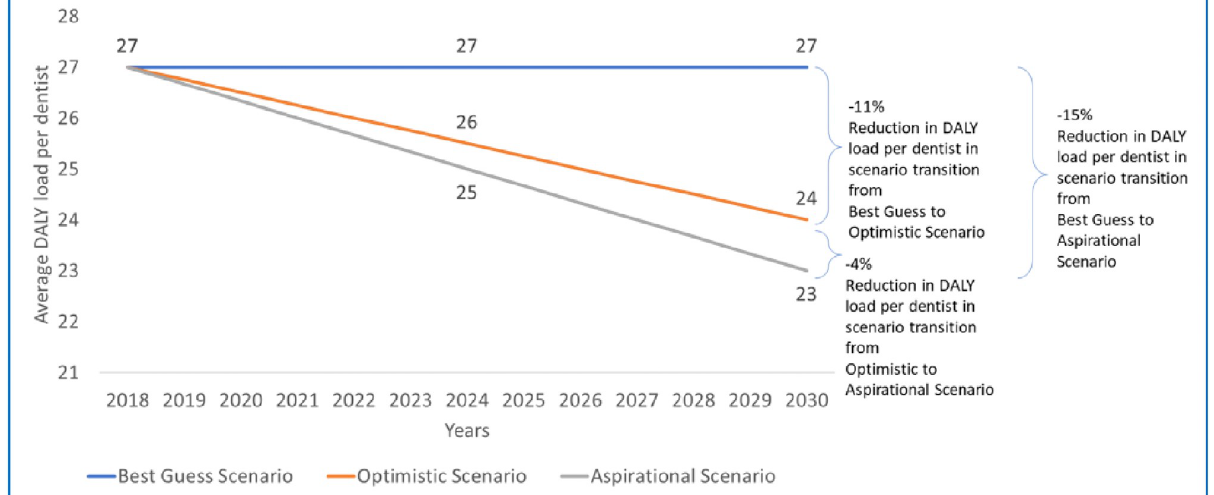
Fig 2. Change in national average of DALY load per dentists from 2018 to 2030.